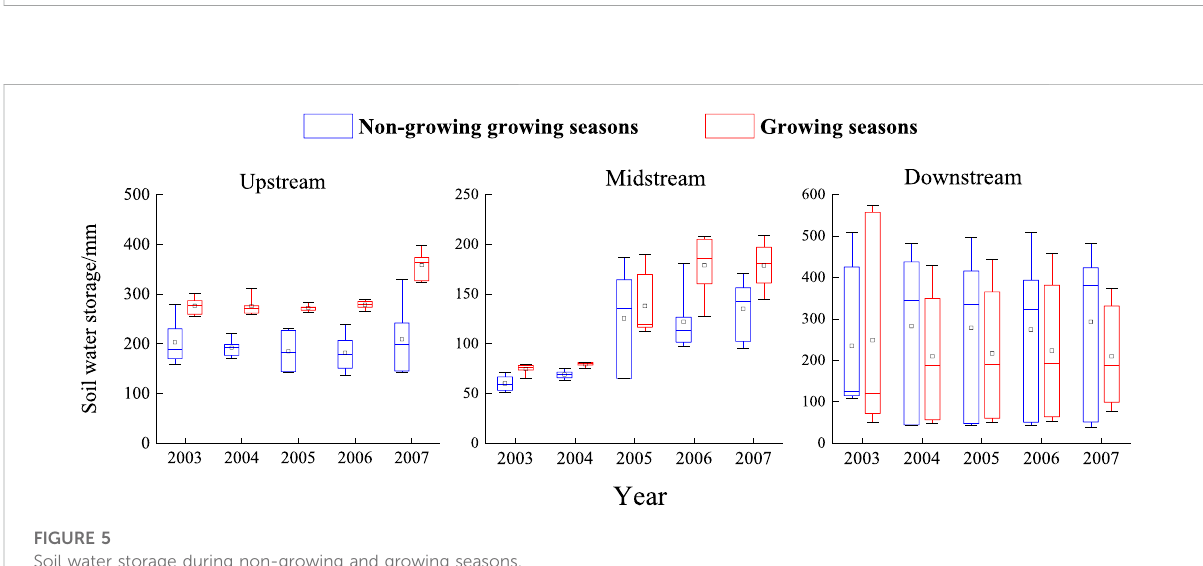
FIGURE 5 Soil water storage during non-growing and growing